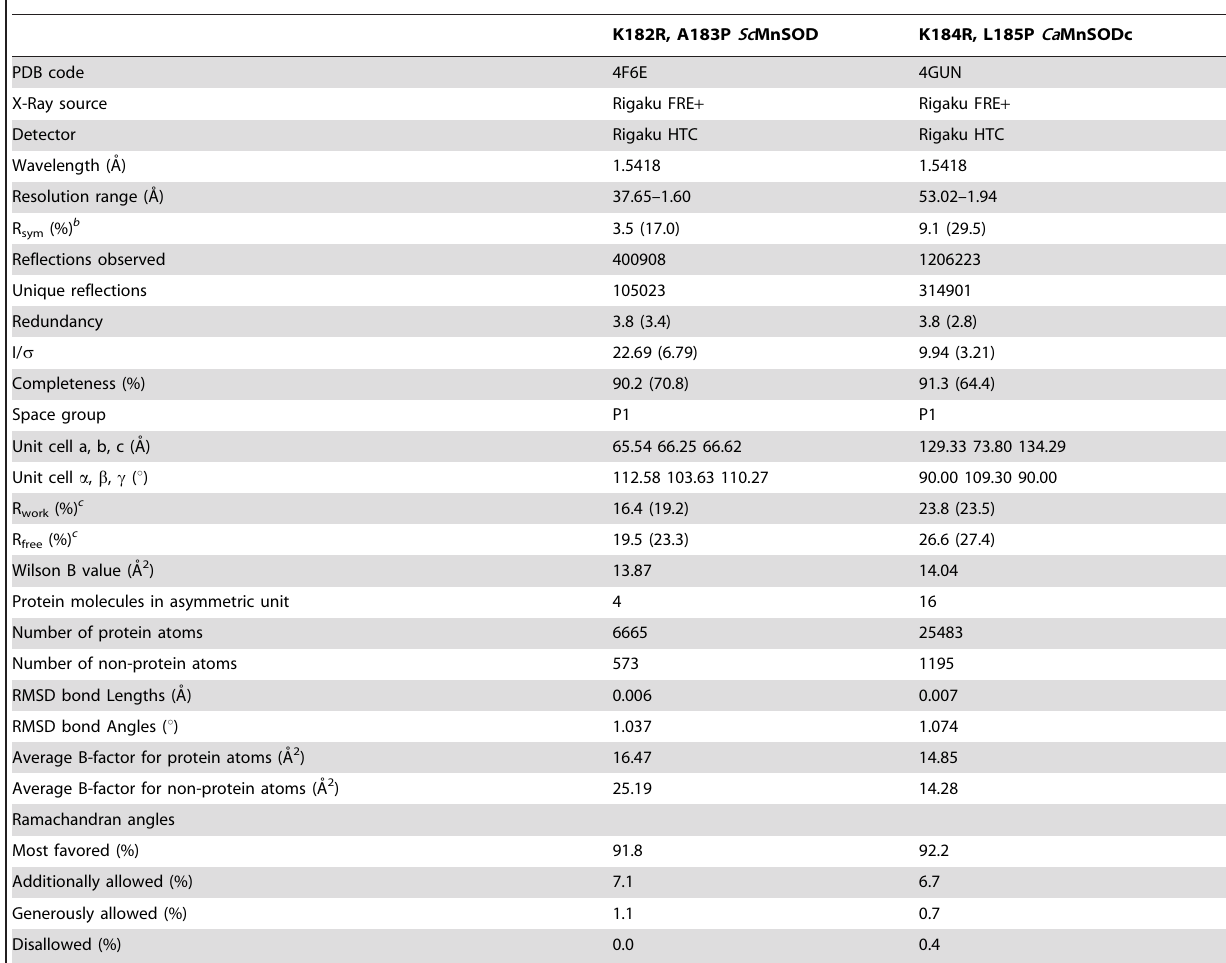
Table 1. X-ray Data Collection and Refinement Statistics a